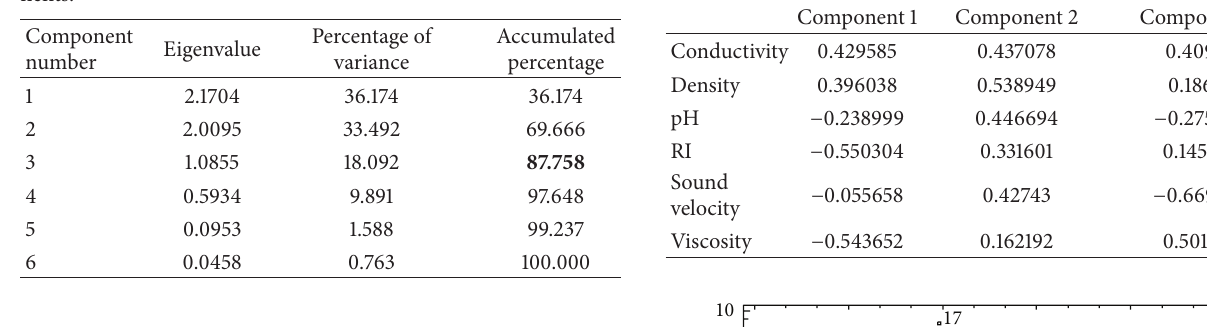
Table 2: Table of variance contribution for the principal compo- nents.